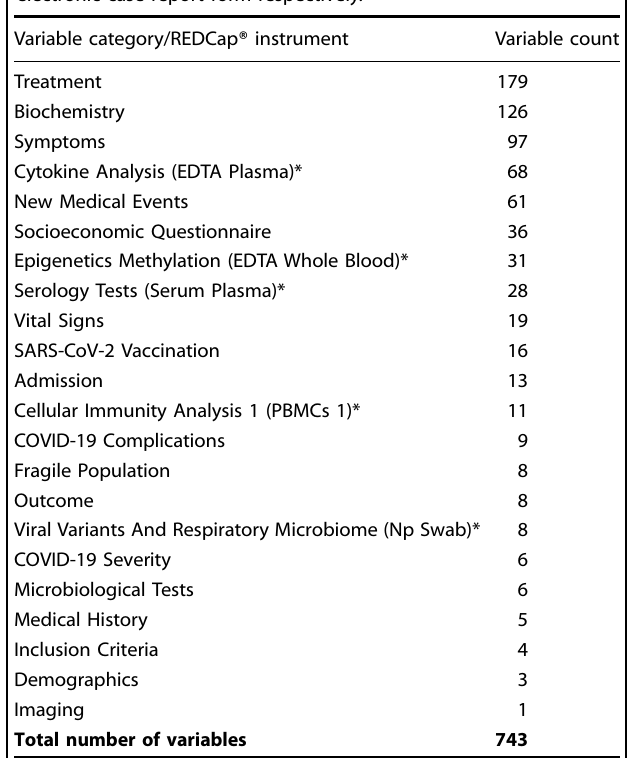
Table 3. Overview of common variables used as part of the metadata for the Long-Term Sequelae study ’ s and the Fragile Population study ’ s electronic case report form respectively.